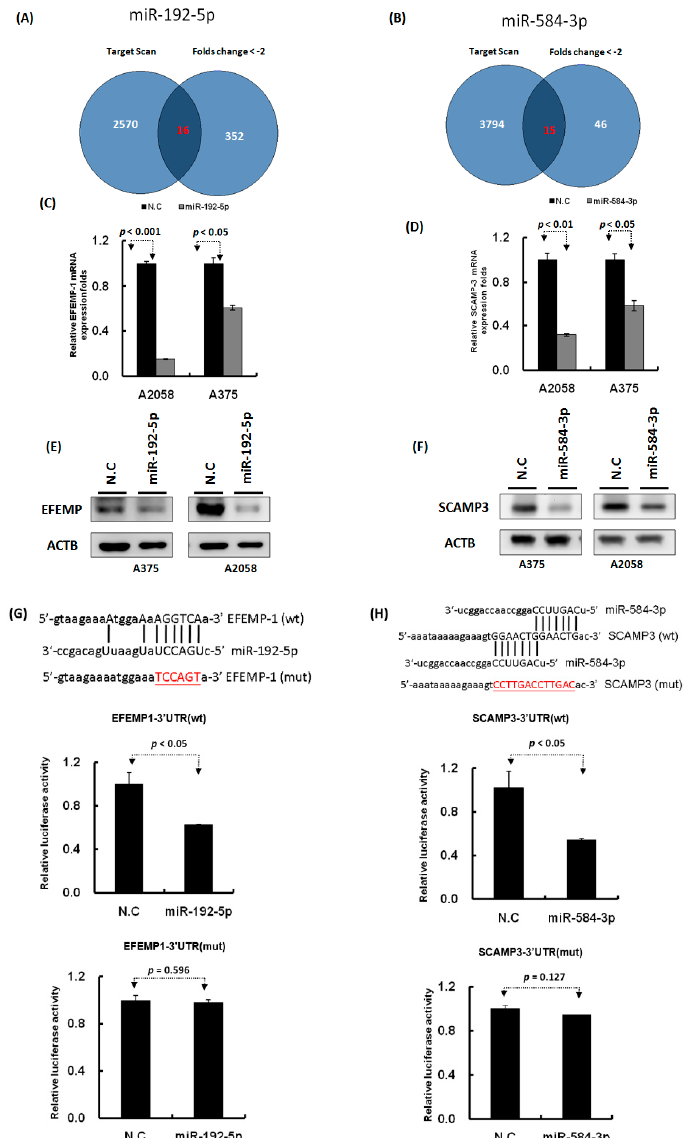
Figure 7. Identification of the putative targets of miR-192-5p and miR-584-3p through microarray and bioinformatics approaches. ( A ) and ( B ): Venn diagrams indicating the numbers of target genes of miR-192-5p and miR-584-3p that were identified using the TargetScan tool and the microarray approach. ( C ) and ( D ): Expression levels of EFEMP1 and SCAMP3 were examined through real-time PCR in melanoma cells with miR-192-5p and miR-584-3p transfection. ( E ) and ( F ): Expression levels of EFEMP1 and SCAMP3 were examined through Western blotting in melanoma cells with miR-192-5p and miR-584-3p transfection. ( G ) and ( H ): Schema of the luciferase constructs (upper panel). The miR-192-5p or miR-584-3p target sequence in the 3 (cid:48) UTR region of their target genes are depicted in the upper panels and the mutant of its 3 (cid:48) UTR was illustrated in red. Relative luciferase activity of the reporter with the wild-type 3 (cid:48) UTR (middle panels) and mutant 3 (cid:48) UTR (lower panels) of EFEMP1 and SCAMP3 genes was determined after co-transfection with miR-192-5p or miR-584-3p mimics in A2058 cells. Firefly luciferase activity served as a transfection